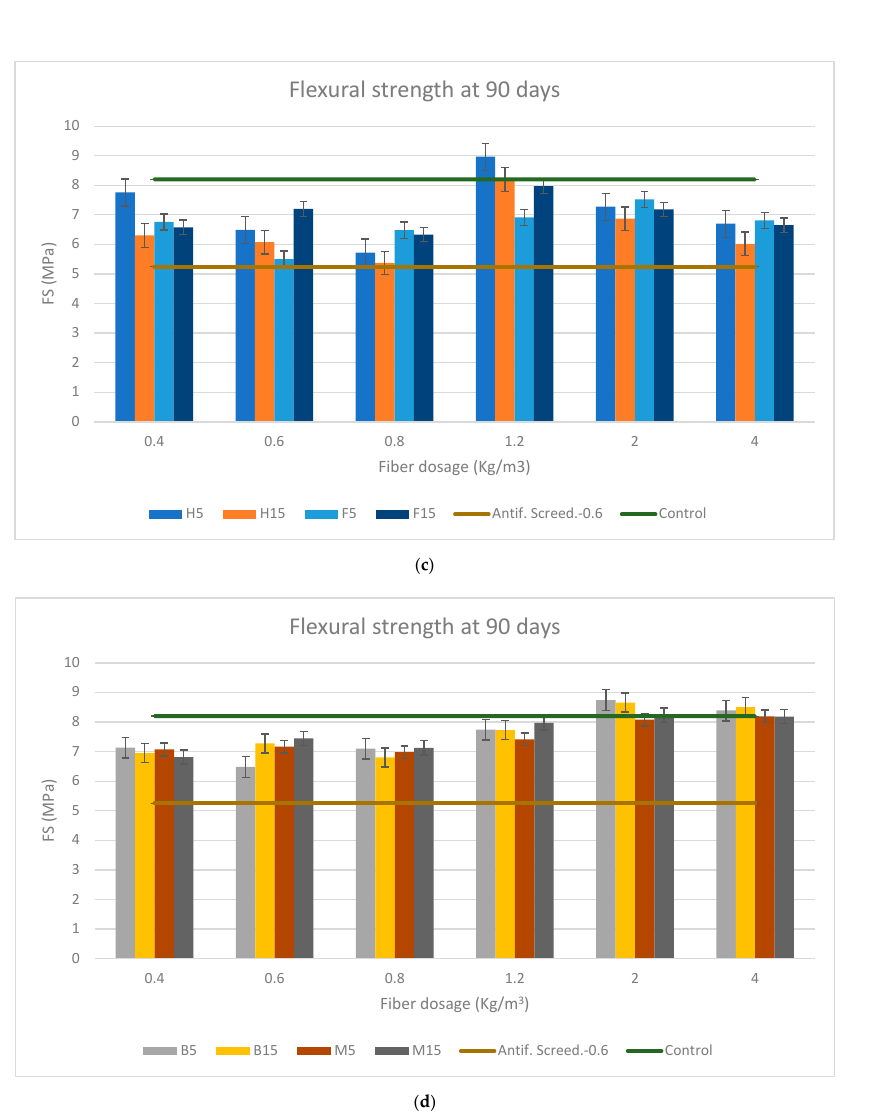
Figure 9. ( a ) Flexural strength at 28 days for soft fibers. ( b ) Flexural strength at 28 days for rigid fibers. ( c ) Flexural strength at 90 days for soft fibers. ( d ) Flexural strength at 90 days for rigid fibers.